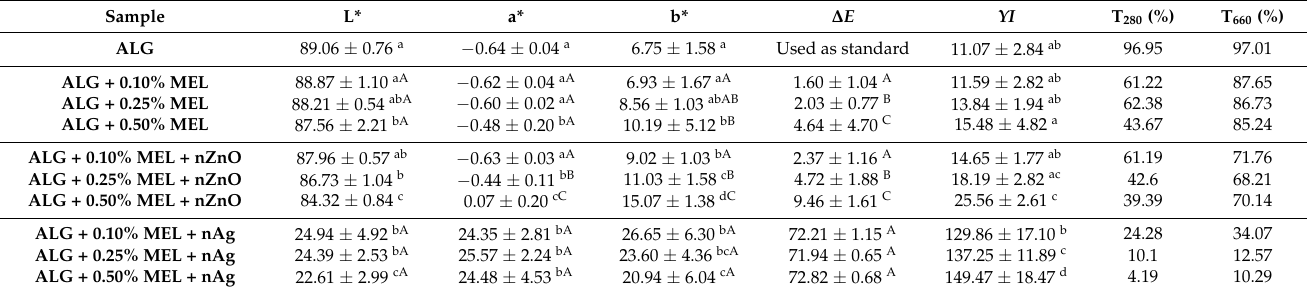
Table 4. Color (L*, a*, b*), total color difference ( ∆ E ), yellowness index ( YI ) and transmittance of unmodified and modified alginate films.